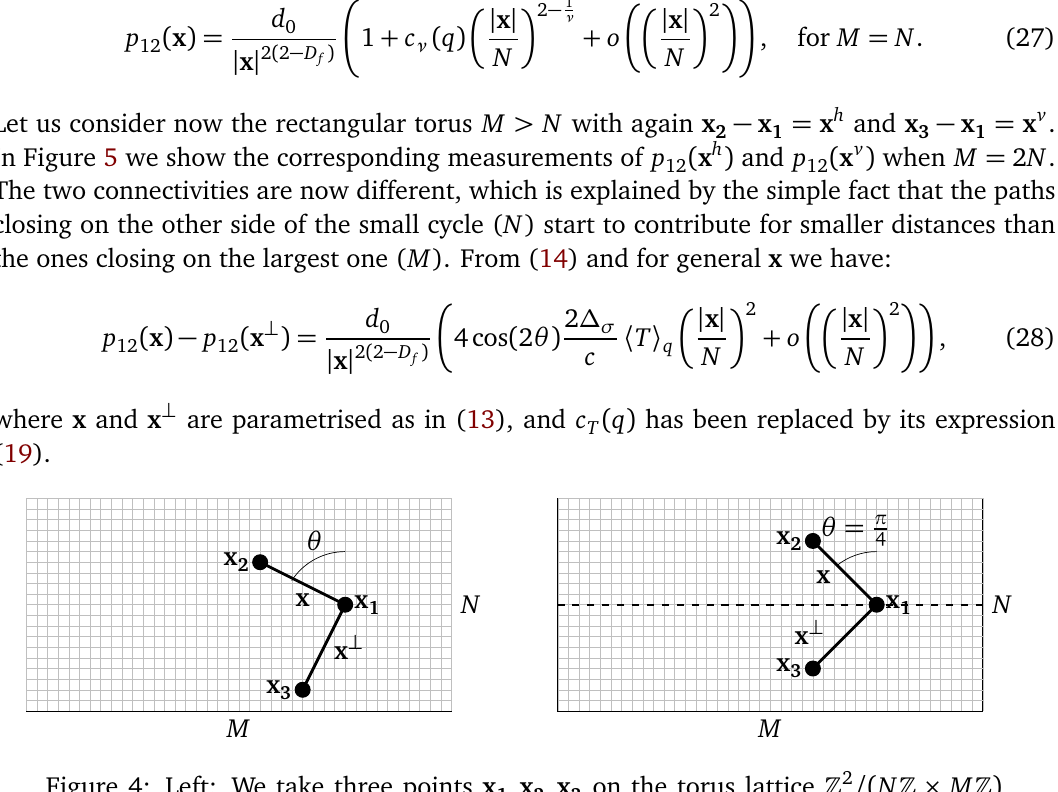
( x ) and p ( x ⊥ ) , 12 12 (dashed line). This 1